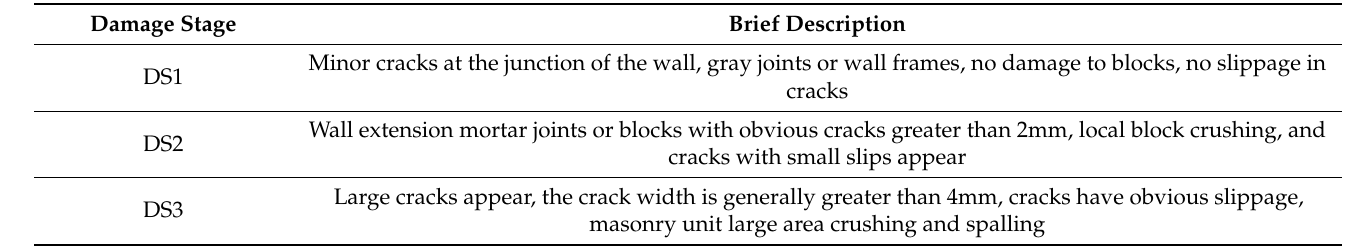
Table 2. Definition of DSs in literature [15].